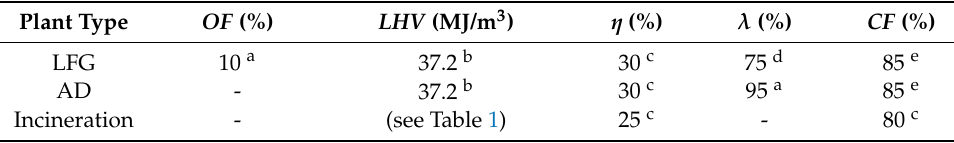
Table 2. Parameters for calculating energy recovery potential from the three technologies. Plant Type OF (%) LHV (MJ/m 3 ) η (%) λ (%) CF (%) LFG 10 a 37.2 b AD - 37.2 b 95 a Incineration - (see Table 1) 25